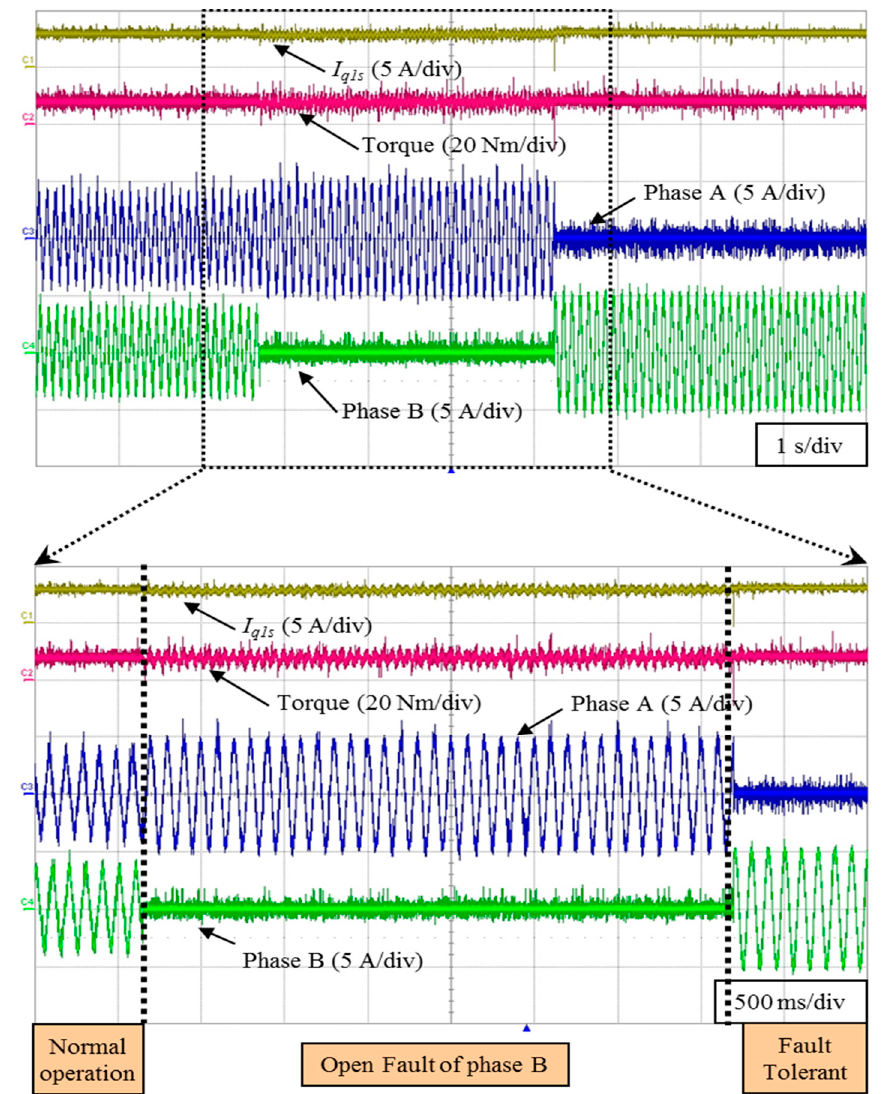
Figure 21. Operation sequence of fault ‐ tolerance control under open fault phase B.